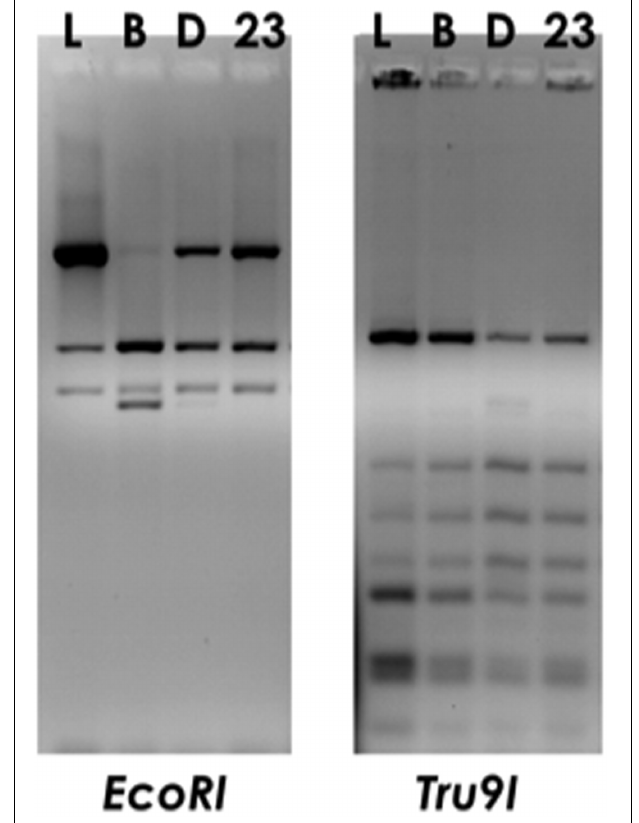
FIGURE 1 | ARDRA profiles of foodborne isolate Lactobacillus delbrueckii 23 (23) obtained by digestion of PCR-amplified 16S rDNA with EcoRI or Tru9I restriction enzymes. Commercial isolates L. delbrueckii subsp. lactis LMG6401 (L), subsp. bulgaricus (B) or subsp. delbrueckii LMG6412T (D) were used as reference subspecies controls.